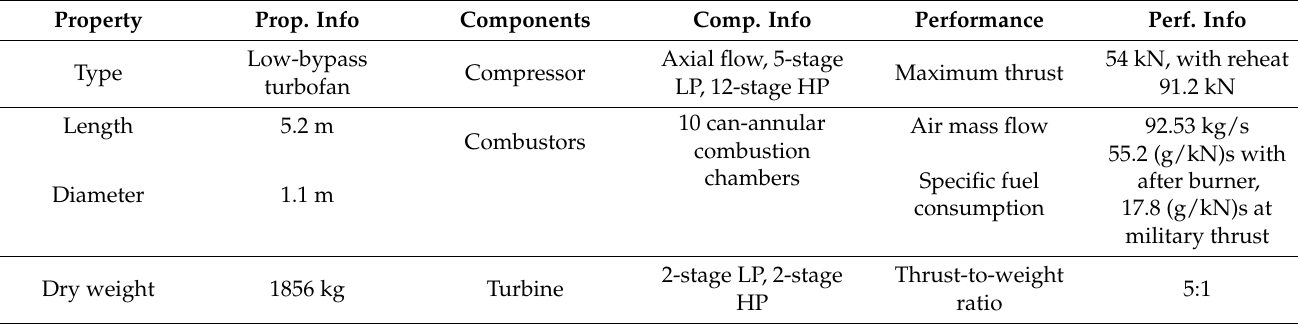
Table 1. Specification of the Spey Mk 202 engine model used to test the different